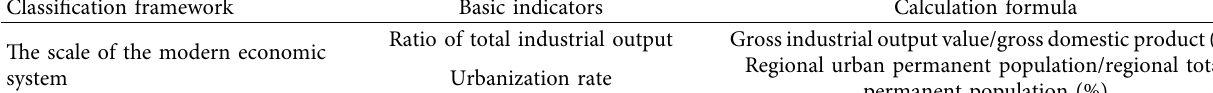
Table 3: Comprehensive evaluation index system of the modern economic system. Classification